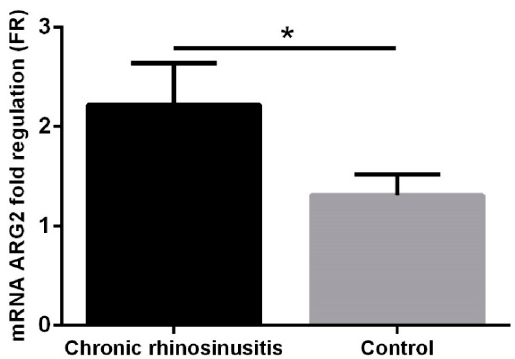
Figure 2. Arginase-2 (ARG2) expression in the group with chronic rhinosinusitis and in the control group. * p < 0.05.